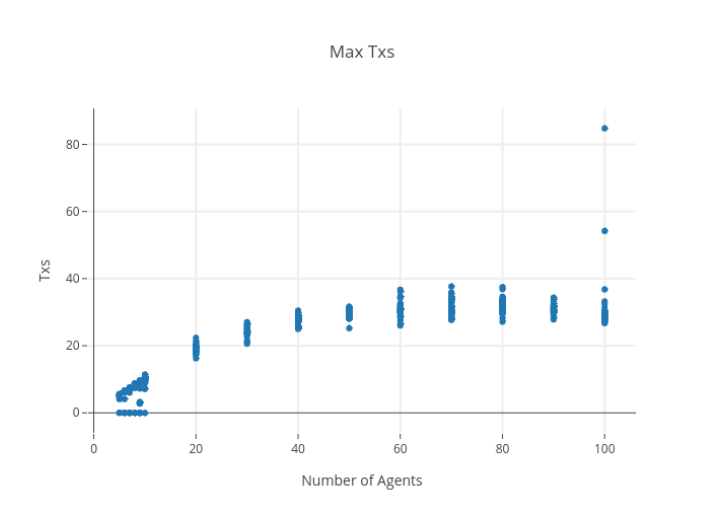
Fig. 5. This figure shows the maximum rate at which transactions occurred during the experiment. These results were obtained from the simulated